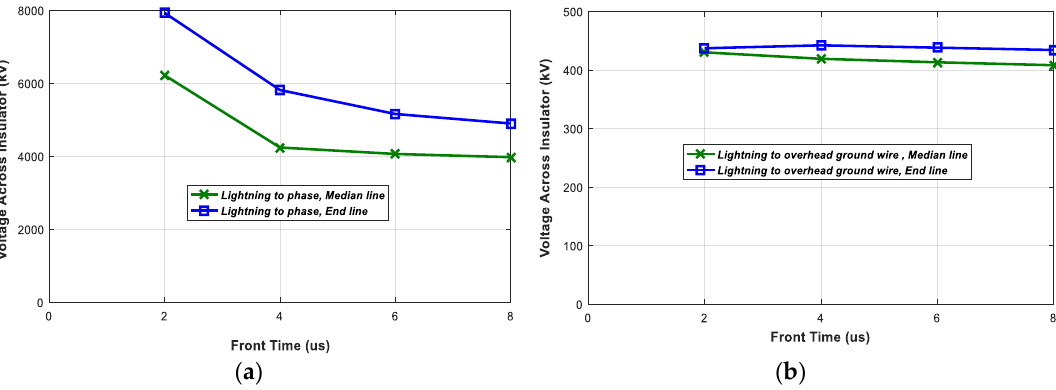
Figure 11. Voltage across the insulator for different front time lightning current wave shapes (grounding distance of overhead ground wire = 200 m, lightning current = 40 kA, ground resistance = 10 Ω, tail time = 77.5 μs); ( a ) Strike to the phase conductor; ( b ) Strike to the overhead ground wire.